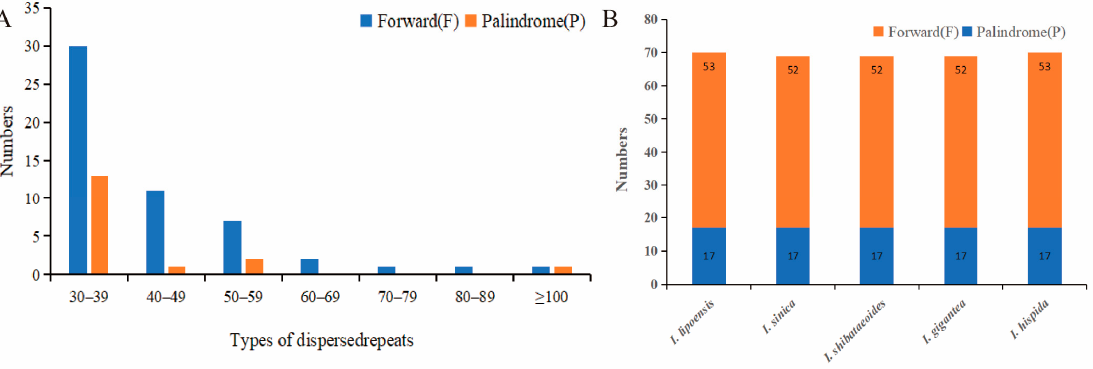
Figure 2. Repetitive sequences in the cp genome of various species. ( A ) Quantification of the different types of long repeats in the cp genome of Indosasa lipoensis . ( B ) Repeat sequence information of the cp genome of the Indosasa genus